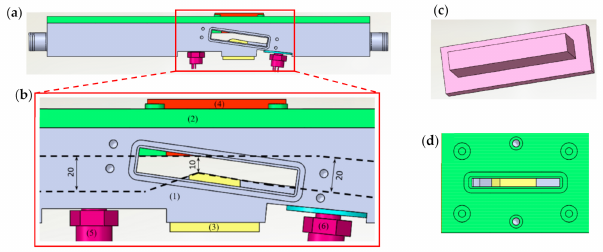
Figure 2. Test section—flow direction from left to right: ( a ) side view of the overall test section, ( b ) the enlarged convergent–divergent section, dimensions in mm, ( c ) side wall insert and ( d ) top view of the convergent–divergent